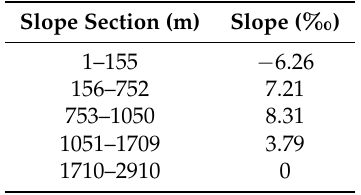
Table 8. The ramp parameters from Houyan to Qianguan.